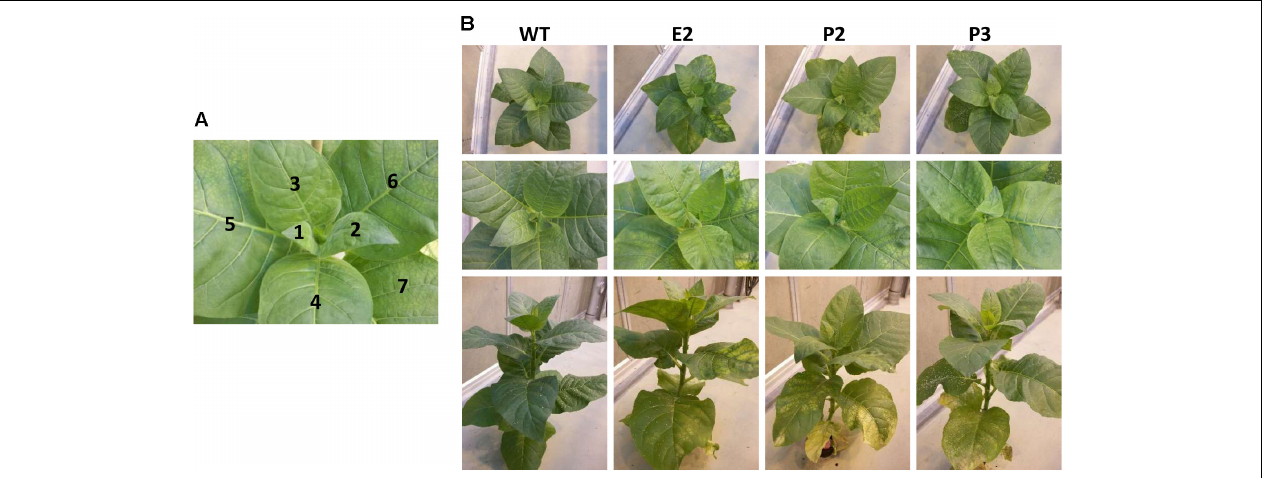
FIGURE 1 | Sulfite reductase (SIR) co-suppression tobacco lines. (A) Leaf numbering indicates the consecutive numbering of leaf samples for harvesting from youngest leaf (L1) to oldest leaf harvested (L7). (B) Tobacco plants at the harvesting stage (approximately 2-month-old plant). Each panel shows a representative plant. Starting with L5 leaf chlorosis becomes visible. The phenotype actually resembles that of sulfate starvation as around vasculature tissue remains greener than between veins. In some cases, a retarded growth phenotype was observed. This P2 plant displays strong chlorosis and necrosis associated with older leaves.